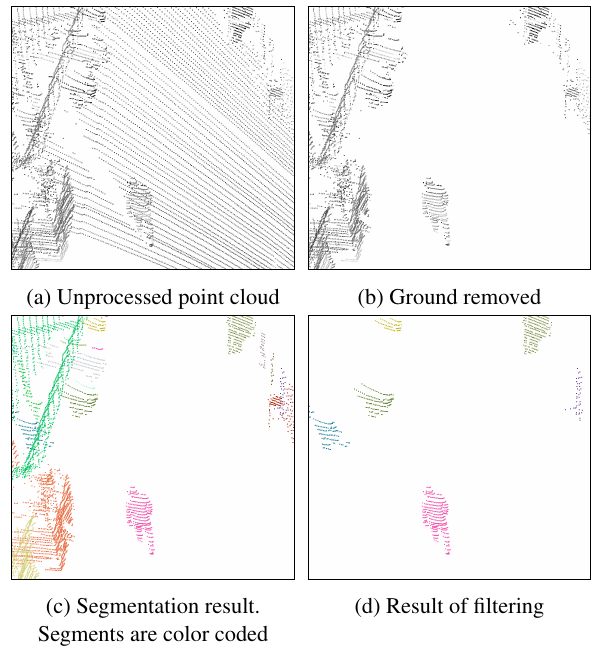
Figure 5. Processing steps of the preprocessing needed on average to completely process a single point cloud (preprocessing and detection). This analysis is done by process- ing the evaluation data with dictionaries in different sizes, but the same other parameters. The result of this analysis is shown in Figure 6.